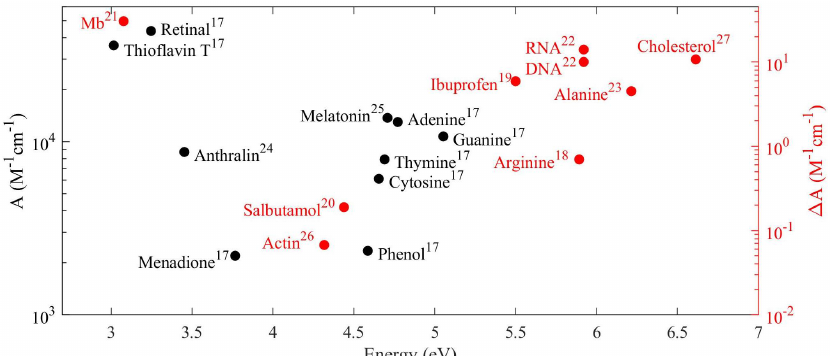
Figure 1. Organic molecules absorption bands: (left axis) molar absorption extinction, A , for some non-chiral molecules; (right axis) difference between molar absorption extinction of left- and right-circularly polarized light, ∆ A , for some chiral